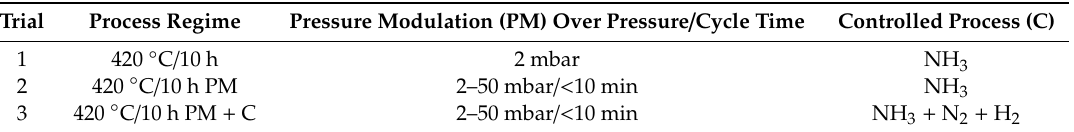
Table 2. Parameter adjustments during gas nitriding